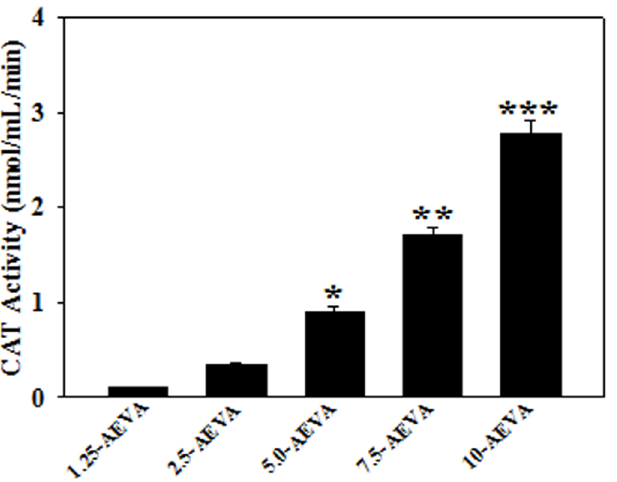
Fig 7. Dose dependent CAT activity of AEVA. Graph is obtained by plotting different concentrations of AEVA (1.25, 2.5, 5, 7.5, and 10 μ g/ μ L) with respect to enzyme activity. “ * ” , “ ** ” , and “ *** ” indicate the significant differences between the effect of 5, 7.5, and 10 μ g μ L -1 AEVA and its lower concentrations respectively ( p < 0.05). Values are mean ± SE (n =